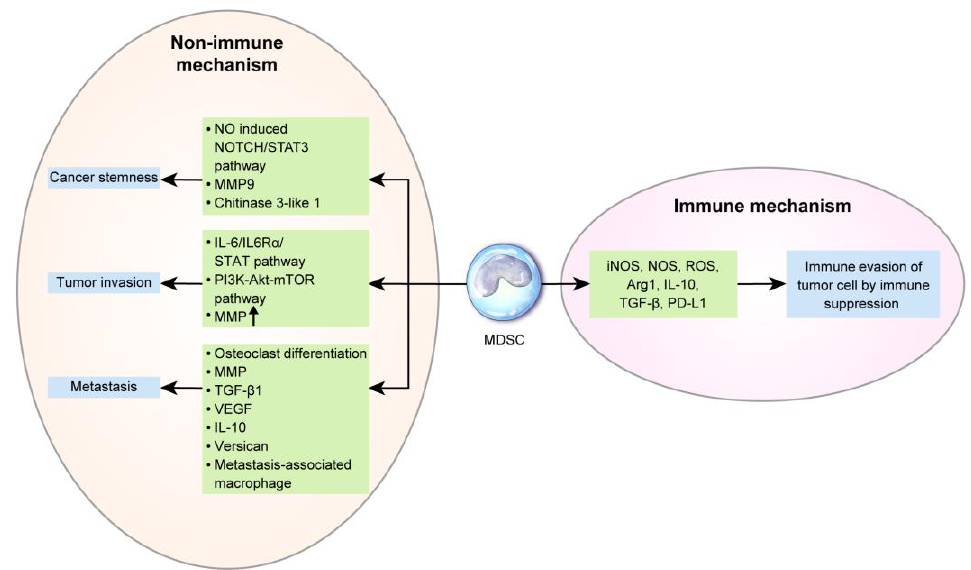
Figure 3. The role of myeloid-derived suppressor cells (MDSCs) in breast cancer: Common immunogenic pathways of MDSCs in breast cancer progression are the induction of immunosuppression by iNOS, NOS, ROS, Arg1, IL-10, TGF- β , and PD-L1, thus facilitating immune evasion of tumor cells. Non-immunogenic mechanisms include the enhancement of cancer stemness by the nitric oxide (NO)-induced Notch / signal transducer and activator of transcription 3 (STAT3) pathway, matrix metallopeptidase (MMP) 9, and chitinase 3-like 1 and the promotion of tumor invasiveness by the IL-6 / IL6R α / STAT pathway, phosphoinositide 3-kinase (PI3K)-Akt-mammalian target of rapamycin (mTOR) pathway, and MMP upregulation. During metastasis, MDSCs di ff erentiate into osteoclasts, which increases osteolytic bone metastasis and promotes MMP, TGF- β 1, VEGF, IL-10, and versican secretion, and into metastasis-associated